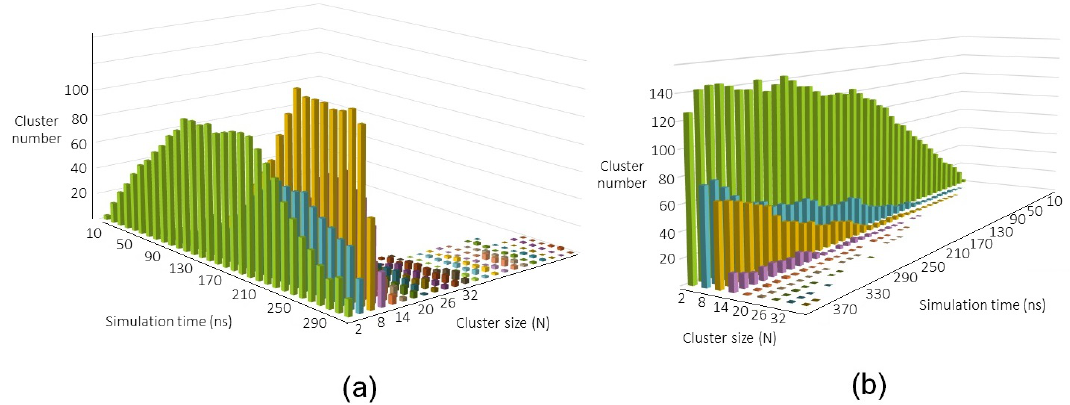
Figure 4. Nucleation and growth picture at ( a ) 1800 K and ( b ) 2400 K.